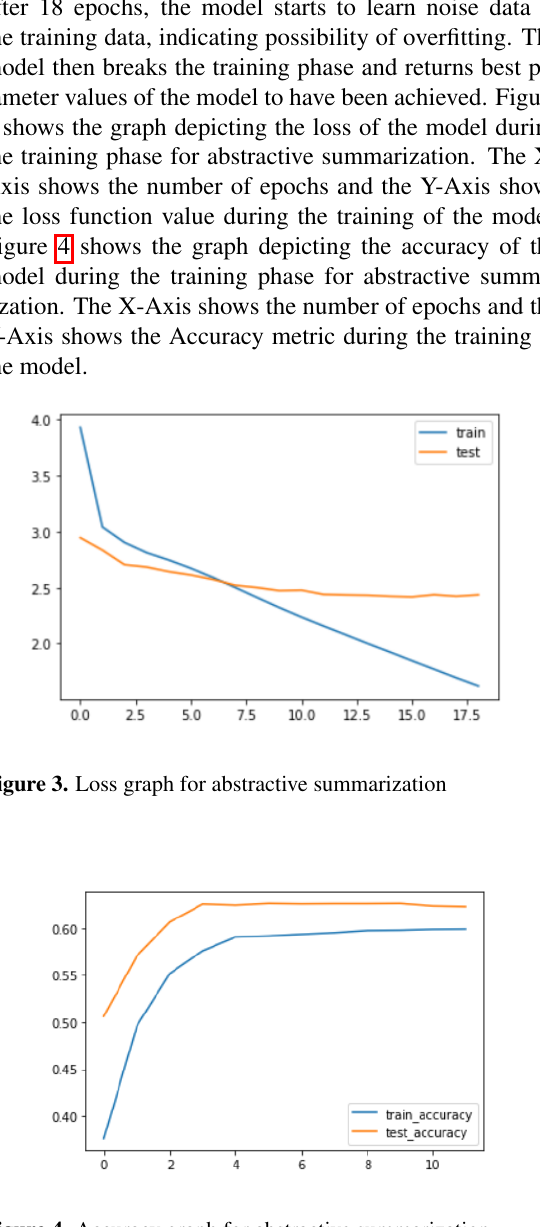
Figure 4. Accuracy graph for abstractive